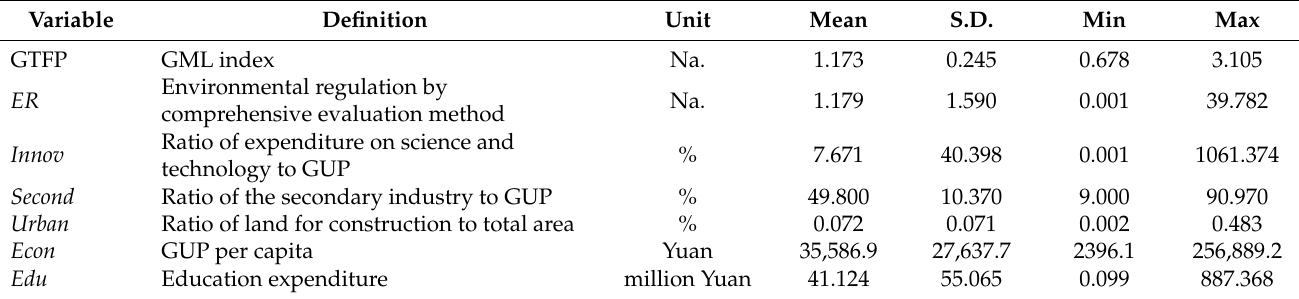
Table 2. Definitions and descriptive statistics of variables involved in this study.